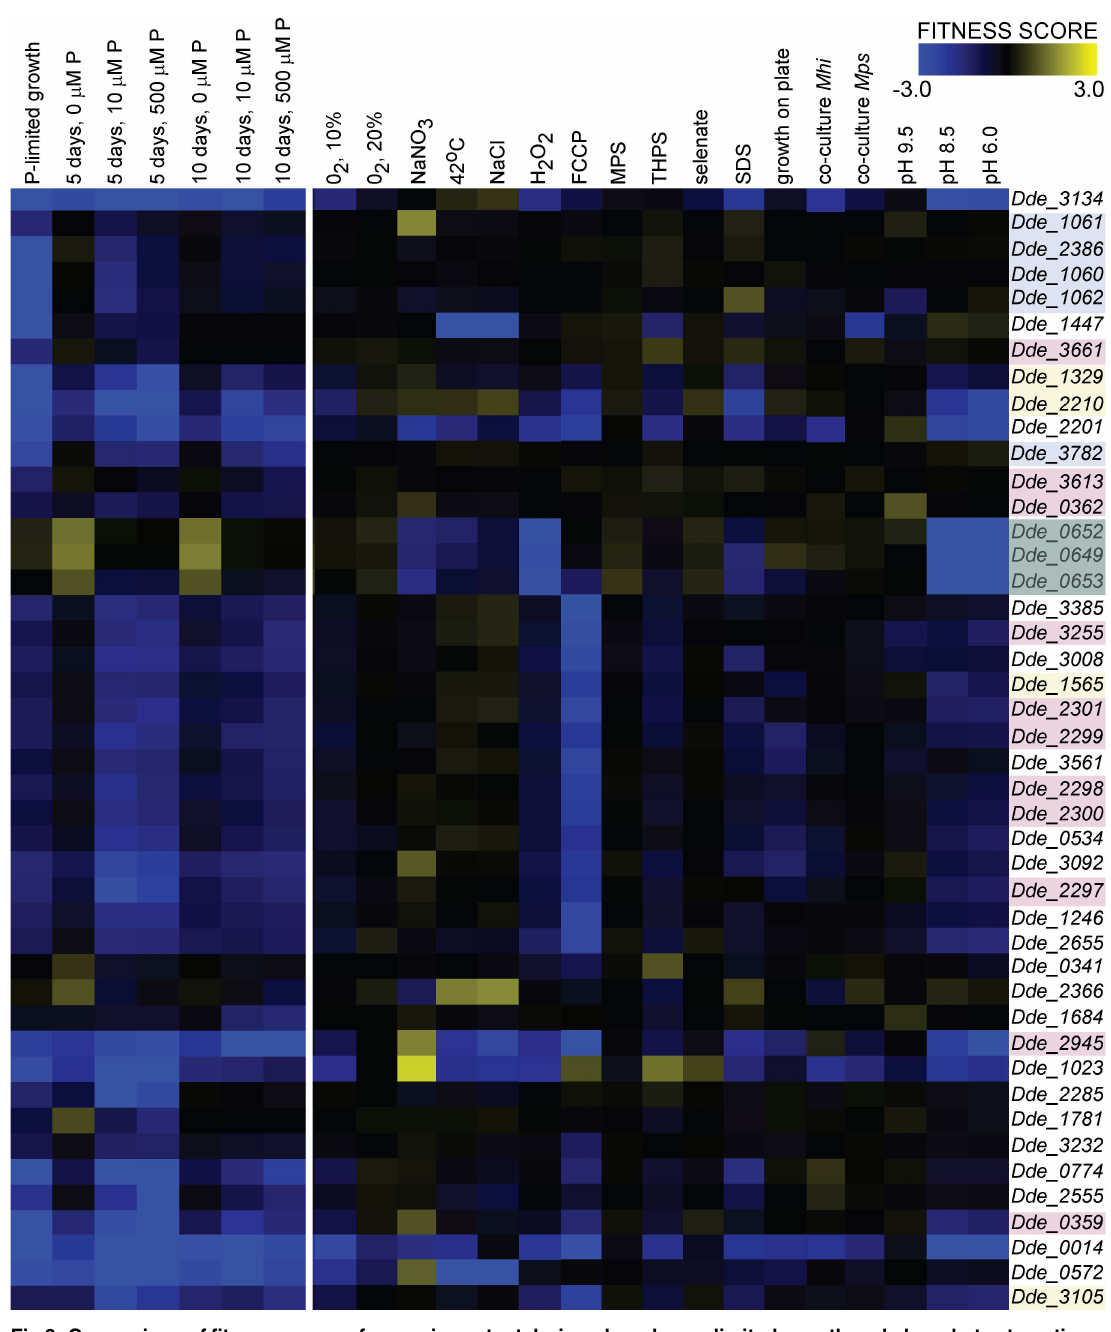
Fig 3. Comparison of fitness scores of genes important during phosphorus-limited growth and phosphate starvation and seventeen other previously tested stressesor growth conditions. Genes with the potential to inform about responses specific to phosphate-limited conditions are listed along the y-axis on the right. Experimental conditions are labeledon top, along the x-axis. The color bar in the top right corner shows colors assignedto the numerical values of fitness scores: negative scores representingfitness defects are blue, positive scores representing fitness benefits are yellow, and fitness-neutral scores are black. The first seven columnsstarting from the left show scores measuredand reportedin the current study, the adjacent seventeencolumns show scores measuredby previous studies and stored in the microbesonline.orgdatabase. The names of genes with predicted direct roles in phosphorus homeostasisare labeledby light blue-colored boxes. The names of genes with predictedor confirmeddirect roles in the biosynthesisof the cell envelope are labeledby rose-coloredboxes. The names of genes with predicted roles in transport are labeledby yellow-colored boxes, those encoding the Hmc complex are labeledby green-colored